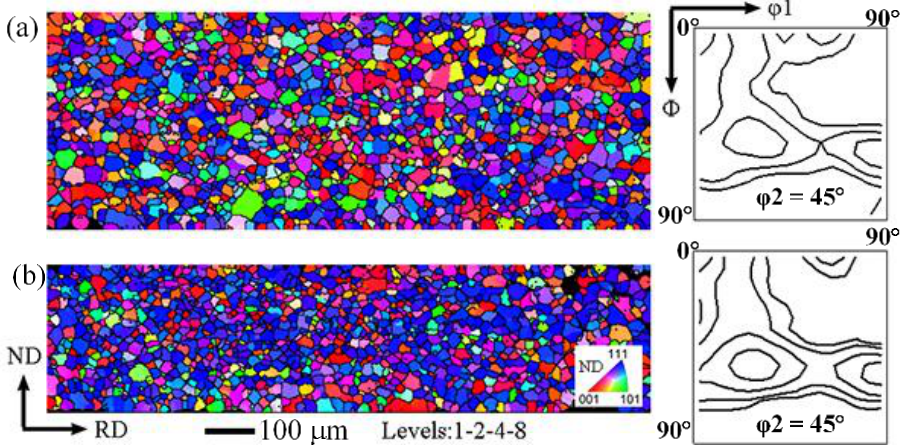
Figure 4. EBSD maps of recrystallized structure and textures in two sheets with different rolling reductions in 2# sample annealed at 900 °C. ( a ) 0.5 mm; ( b ) 0.35 mm.